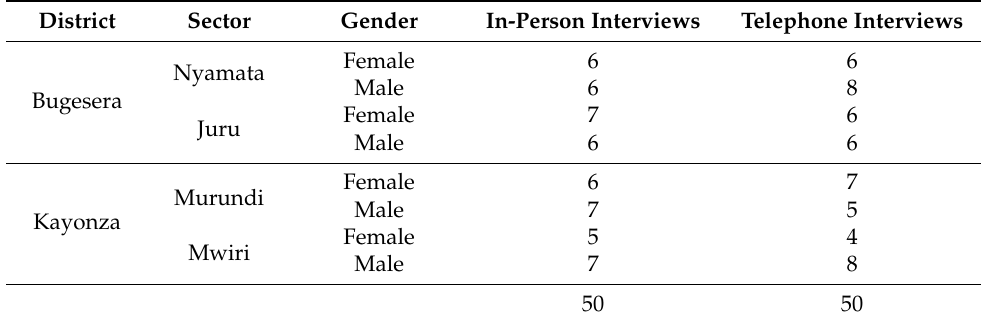
Table 2. Number of in-person and telephone